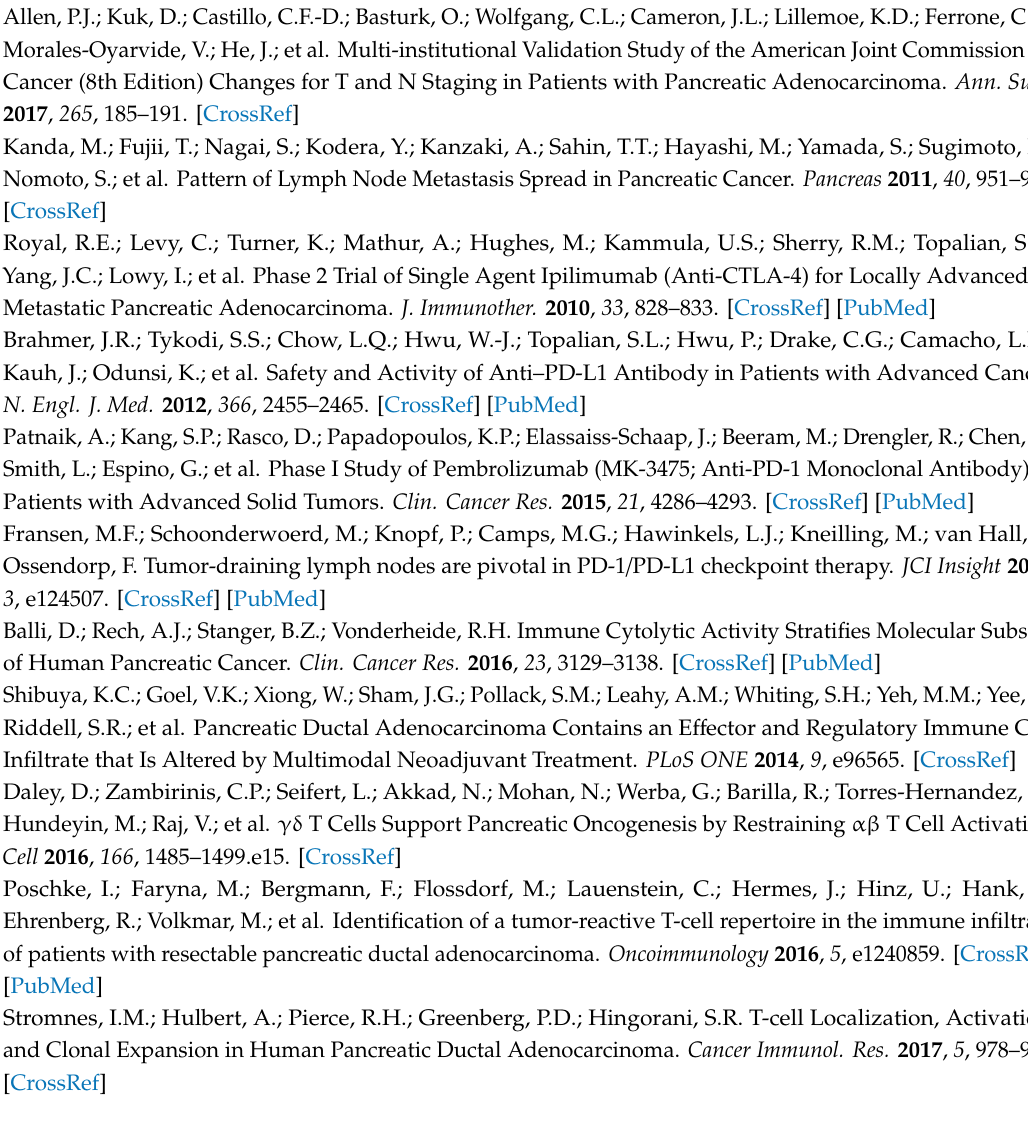
Table S1: Clinicopathologic characteristics of patients in the lymph node cohort, Table S2: Clinicopathologic characteristics of patients in the blood and tumor